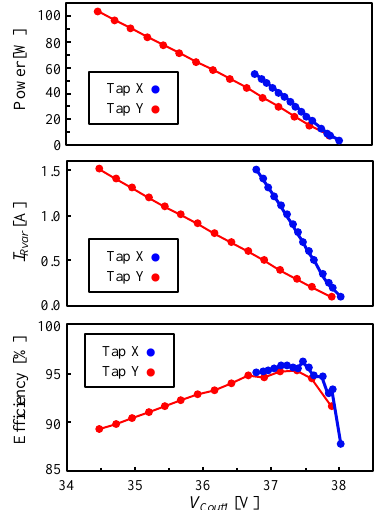
Figure 14. Measured power conversion efficiencies and output characteristics.